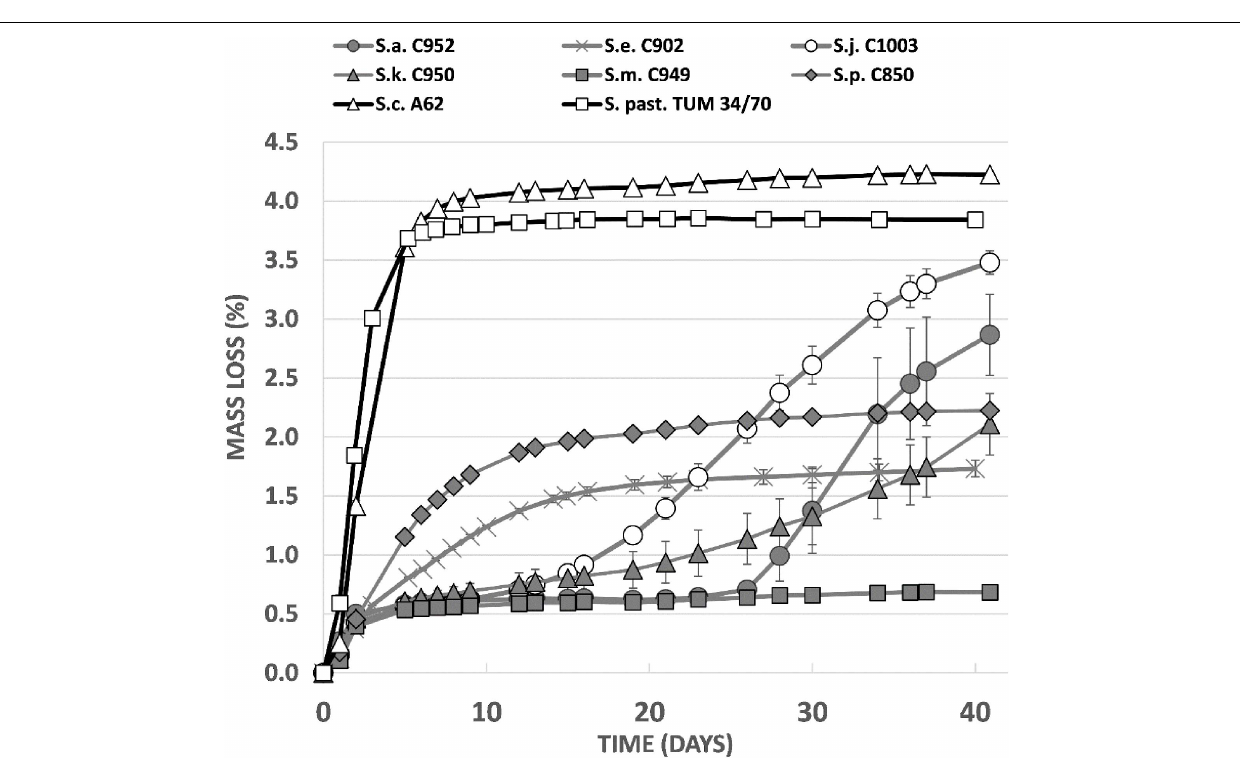
FIGURE 6 | Fermentation performance (measured as loss of mass of the fermentor) in comparison between Saccharomyces type strains in 12 ◦ P all-malt wort at 15 ◦